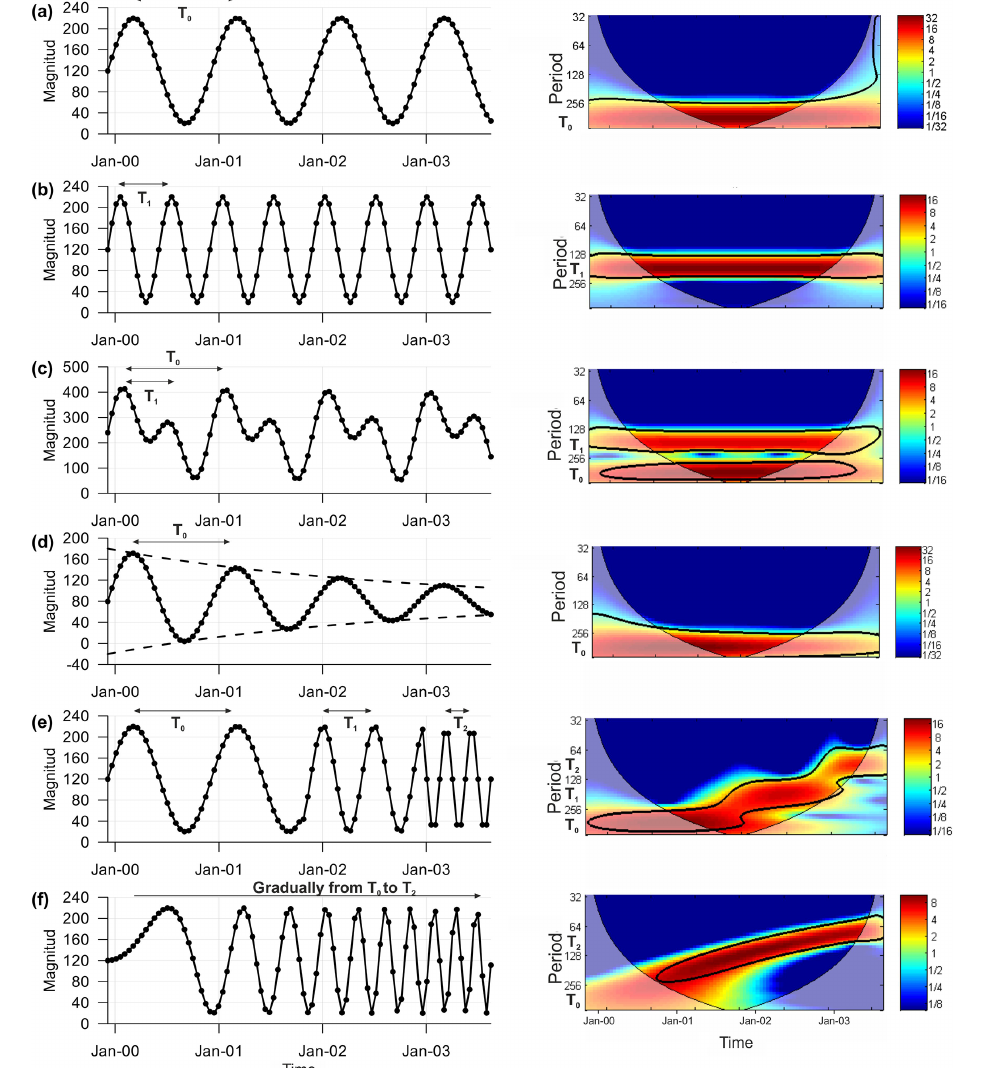
Figure 1. Synthetic time series of groundwater level and their respective CWT power spectra: (a) one-year ( T 0 ) period sine function; (b) half-year ( T 1 ) period sine function; (c) function resulting from the sum of functions (a) and b) ; (d) damped T 0 period sine function; (e) variable ( T 0 , T 1 and T 2 ) period sine function; (f) linearly variable period (from T 0 to T 2 ) sine function (linear chirp function). The colour bar represents the wavelet power of time series that ranges from blue (low) to red (high). The 5% significance level against red noise is shown by the black